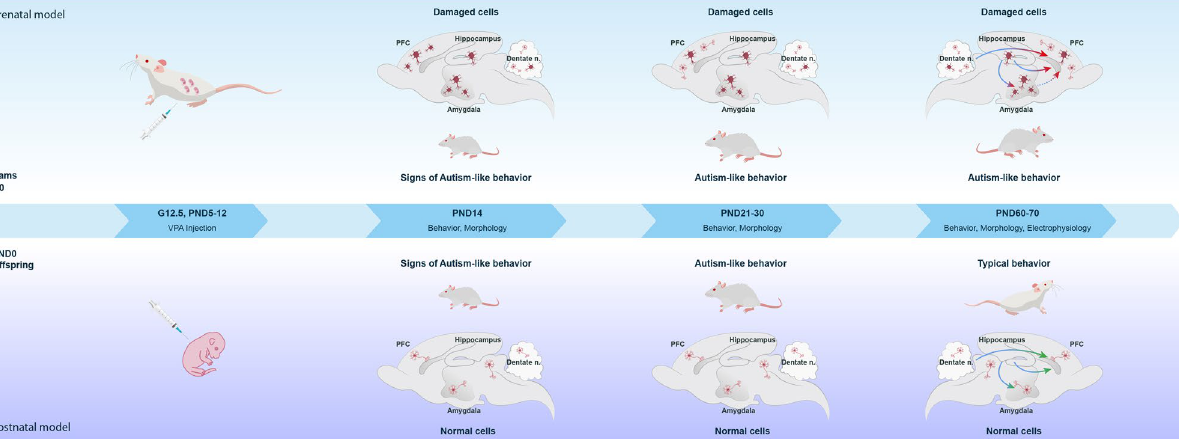
Figure 7. Graphical illustration of behavioral, morphological and electrophysiological changes in pre- and postnatal VPA-induced ASD models in different time periods. In prenatal model increasing ASD-like behavior associated with cellular damage of PFC, amygdala, hippocampus and dentate n. of cerebellum neurons ( damaged cells are in red ) on PND 14, PND (21–30), and PND 60–70 is shown ( upper panel ). Red arrows trace functional alterations between structures analyzed by electrophysiological studies on PND 70. In postnatal model ASD-like behavioral changes associated with normal cellar structure of PFC, amygdala, hippocampus and dentate n. of cerebellum neurons, as well as typical behavior on PND 60–70 are shown. Green arrows trace functional connections between structures analyzed by electrophysiological studies on PND 70 ( bottom panel